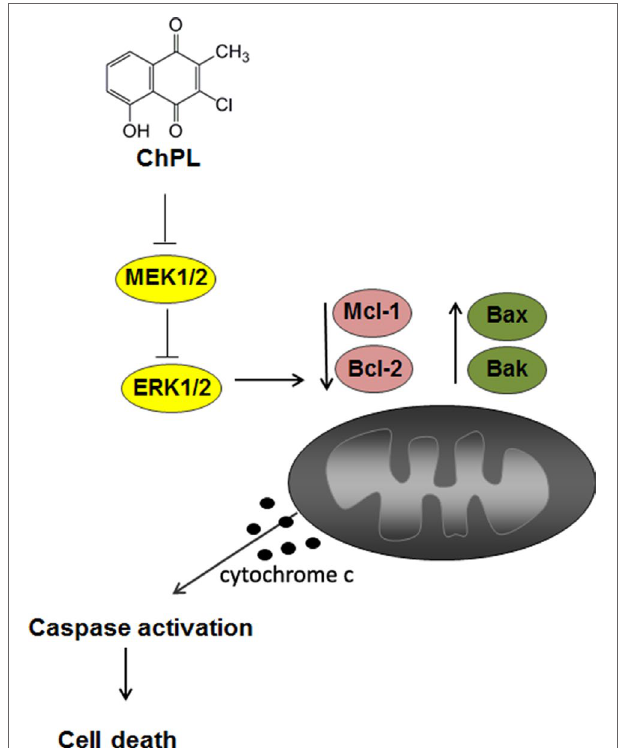
FIGURE 6 | The proposed mechanism of apoptosis induction by 3-cloroplumbagin (ChPL) in breast cancer cells. ChPL inhibits MAP kinase signaling and induces apoptosis through the activation of the mitochondria- mediated pathway, involving the downregulation of anti-apoptotic proteins Mcl-1 and Bcl-2 and upregulation of pro-apoptotic Bcl-2 family